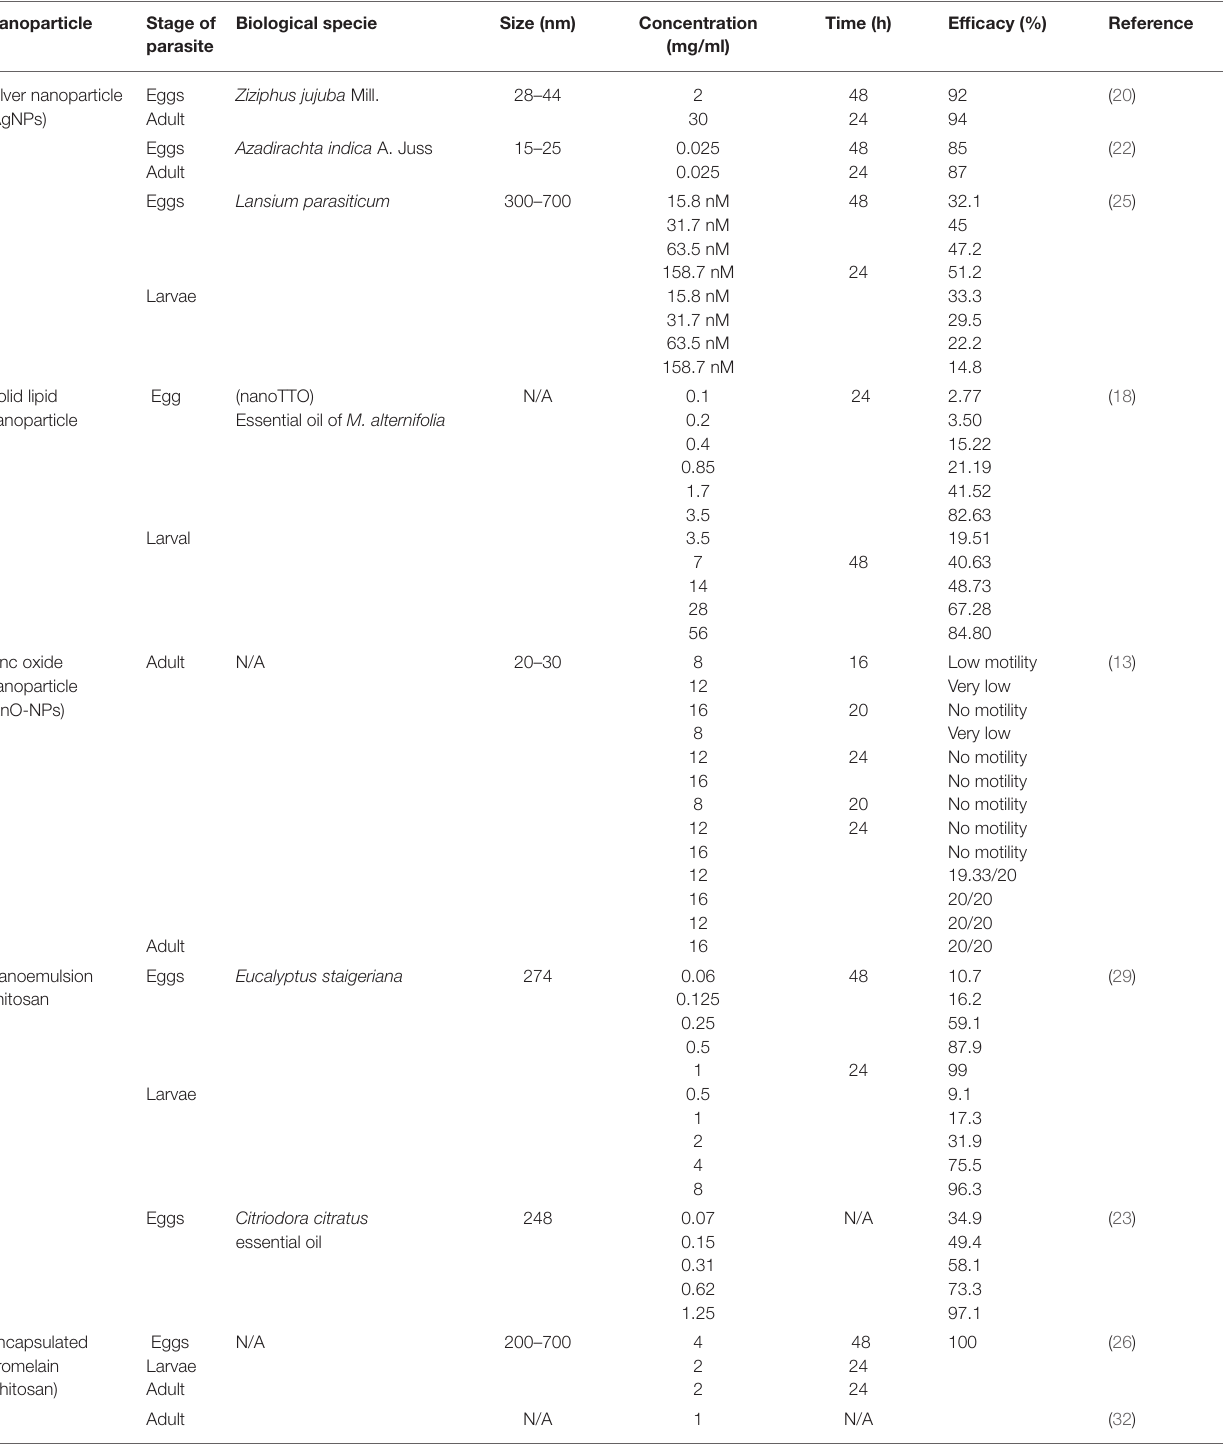
TABLE 2 | In vitro efficacy of nanoparticles against H. contortus . Nanoparticle Stage of Biological specie parasite